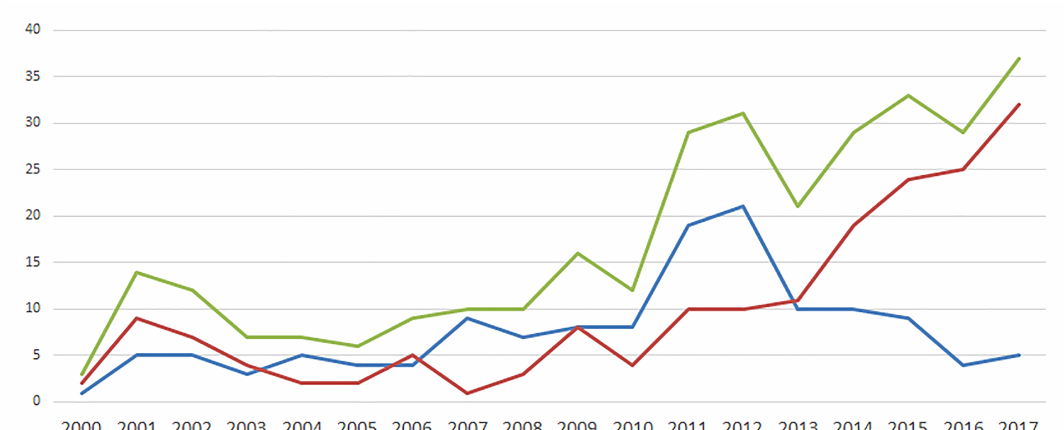
Figure 5. Research (in blue) versus management (in red) initiated archaeo-geophysical surveys in Norway. The total number of surveys is shown in green. Graphic by Arne Anderson